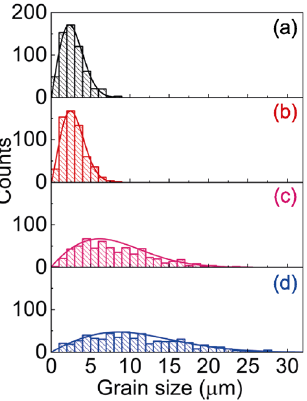
Fig. 11 Grain size distributions of (Y 0.93 Yb 0.05 La 0.005 Zr 0.015 ) 2 O 3 ceramics sintered at T = 1750 ℃ (a), 1775 ℃ (b), 1800 ℃ (c), and 1825 ℃ (d) for 10